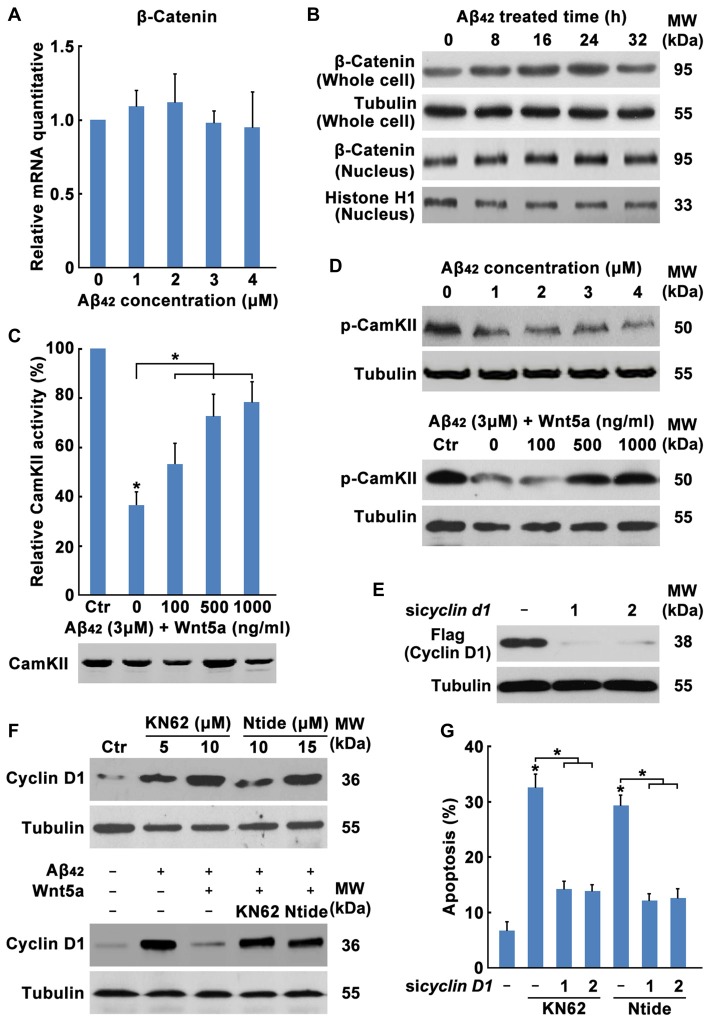
Wnt5a/CaMKII pathway down-regulates the expression of Cyclin D1. (A) DIV7 cortical neurons were treated with Aβ42 at indicated concentrations for 12 h, total RNA was extracted and analyzed by Q-PCR. (B) DIV7 cortical neurons were treated with 3 μM Aβ42 at indicated times, total protein or nuclear protein was extracted and analyzed by Western blotting. (C) DIV6 cortical neurons were treated with 3 μM Aβ42 with or without recombinant Wnt5a protein at indicated concentrations for 12 h. CamKII activity was determined using SignaTECT® Calcium/Calmodulin-Dependent Protein Kinase Assay System (Upper panel). The input total CamKII was analyzed by Western blotting (Lower panel). (D) DIV7 cortical neurons were treated with Aβ42 at indicated concentrations (Upper panel) or treated with 3 μM Aβ42 with/without recombinant Wnt5a protein at indicated concentrations (Lower panel) for 16 h, total protein was extracted and analyzed by Western blotting. (E) DIV7 cortical neurons were treated with KN62 or Calmodulin Kinase II Ntide, Myristoylated (Ntide) at indicated concentrations for 16 h (Left panel), or DIV7 cortical neurons were treated with 3 μM Aβ42 with/without 500 ng/ml recombinant Wnt5a protein or 10 μM KN62 or 15 μM Ntide as indicated for 16 h (Right panel), total protein was extracted and analyzed by Western blotting. (F) HEK239 cells were transfected with Flag-Cyclin D1 and Cyclin D1 siRNAs for 12 h, then cells were subjected to immunoblot detection. (G) DIV7 cortical neurons were treated with 10 μM KN62 or 15 μM Ntide and transfected with or without Cyclin D1 siRNAs for 24 h (Left panel), then apoptosis was determined. MW, molecular weight; kDa, kilodalton. All data in this figure represent the means ± SEM of three independent experiments. *P < 0.05.